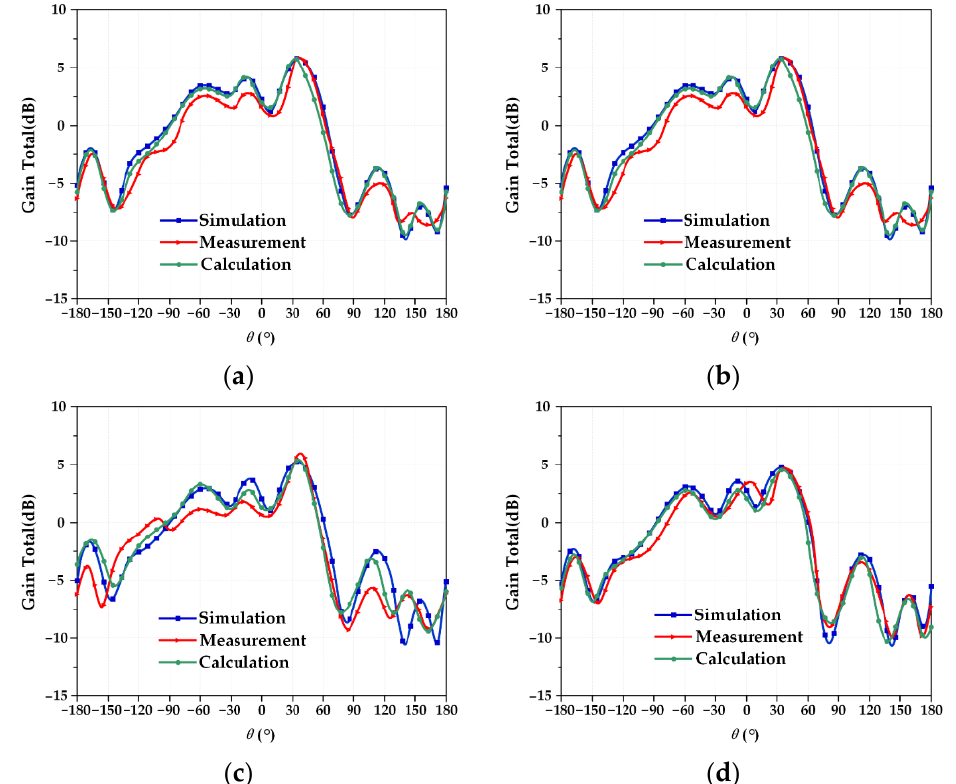
Figure 19. Mode 3 antenna radiation pattern under four working conditions. ( a ) Working condition 0; ( b ) working condition 1; ( c ) working condition 2; ( d ) working condition 3.